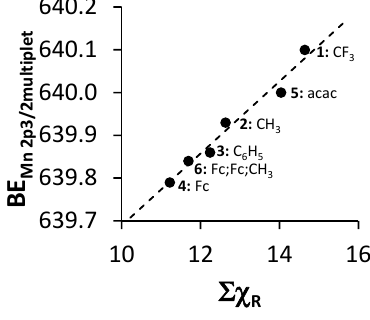
Figure 6. Relationship between the binding energy of the first peak of the mer isomers’ fitted multiplet splitting peaks of the Mn 2p 3/2 photoelectron line of 1 – 3 or the first peak of the fitted multiplet splitting peaks of the Mn 2p 3/2 phototelectron line of 4 – 6 (BE Mn2p3/2multiplet ) and Σχ R .